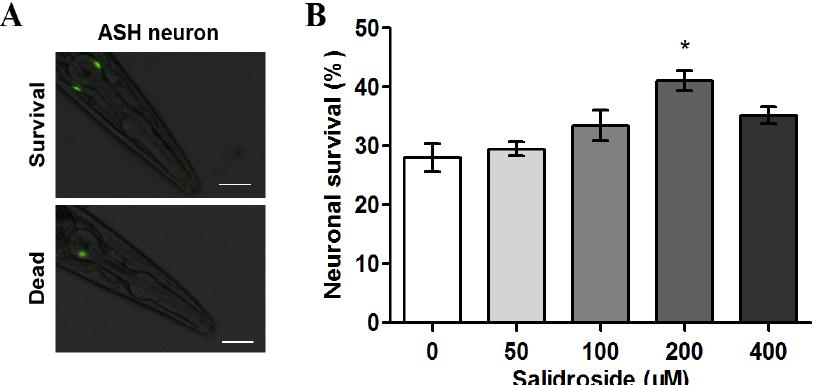
Figure 1. Effect of salidroside on the survival of ASH neurons in C. elegans HA759. ( A ) Micrographs of HA759 nematodes expressing Htt-Q150 in ASH neurons. Death of ASH neurons is assessed by loss of bilateral GFP fluorescence. Scale bars, 20 μ m; ( B ) Survival rate of ASH neurons after salidroside treatment. The nematodes were